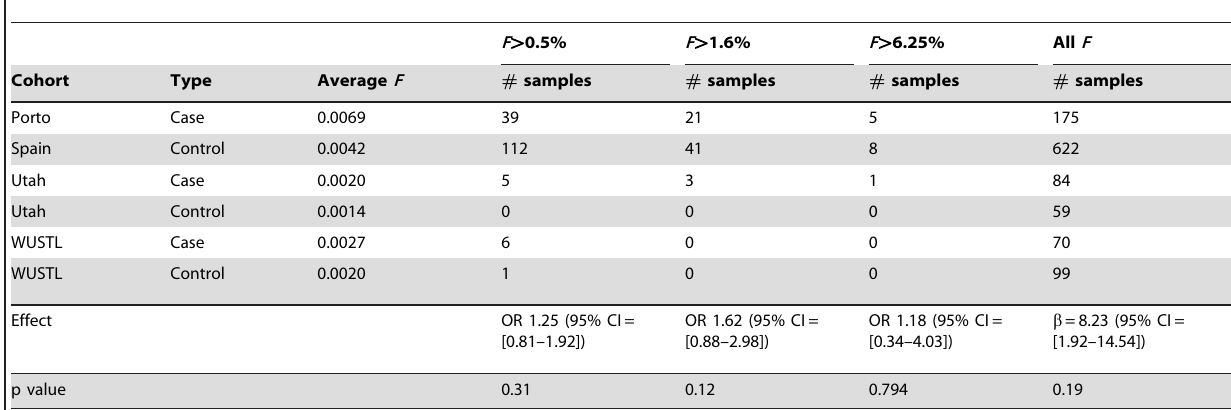
Table 3. Summary of inbreeding coefficient estimates across cohorts, and association testing.